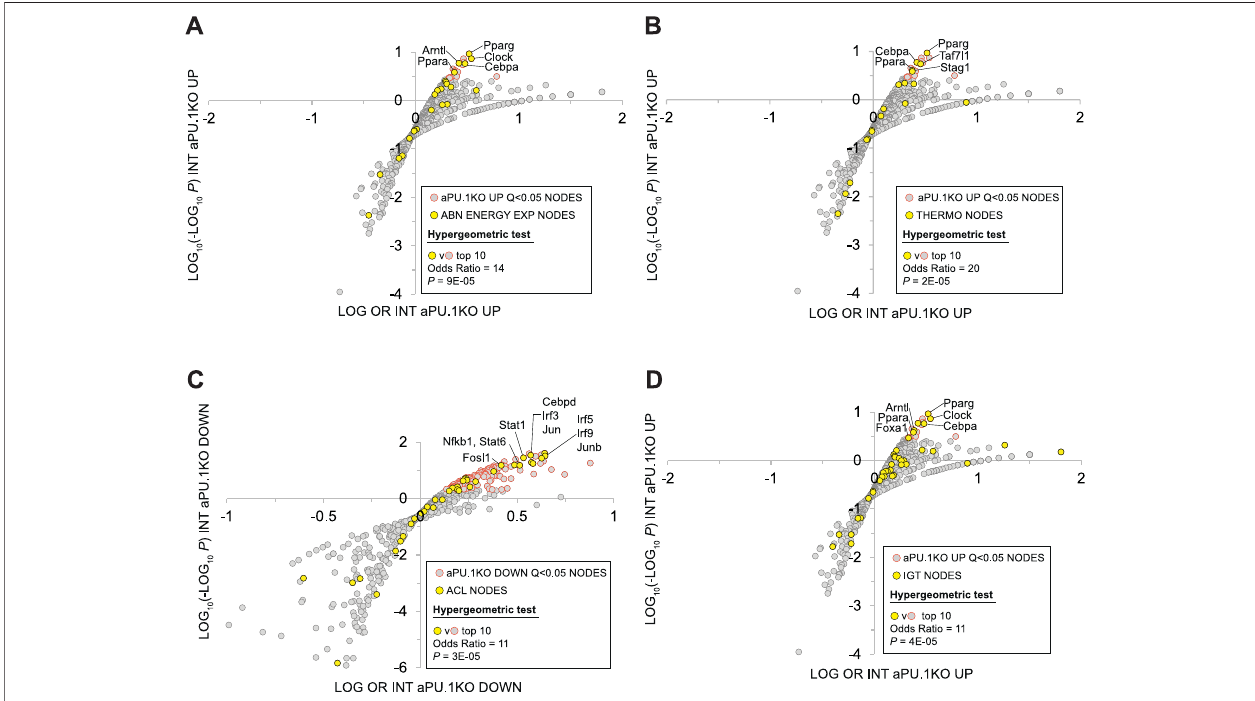
FIGURE 8 | Mammalian Phenotype Ontology Analysis Of Nodes With Signi fi cant HCT Intersections With aPU.1KO-Induced and Repressed Gene Sets. (A) Enrichment of nodes encoded by genes that map to the MPO term “ abnormal energy expenditure ” (AEE) among nodes that have signi fi cant HCT intersections with aPU.1KO-induced genes. (B) Enrichment of nodes encoded by genes that map to the MPO terms “ decreased brown adipose tissue amount ” , “ decreased core body temperature ” or “ impaired adaptive thermogenesis ” (collectively referred to as THERMO genes) among nodes that have signi fi cant HCT intersections with aPU.1KO-induced genes. (C) Enrichment of nodes encoded by genes that map to the MPO term “ abnormal cytokine levels ” (ACL) among nodes that have signi fi cant HCT intersections with aPU.1KO-repressed genes. (D) Enrichment of nodes encoded by genes that map to the MPO term “ impaired glucose tolerance ” (IGT) among nodes that have signi fi cant HCT intersections with aPU.1KO-induced genes. Please refer to the Methods for details of the analysis.